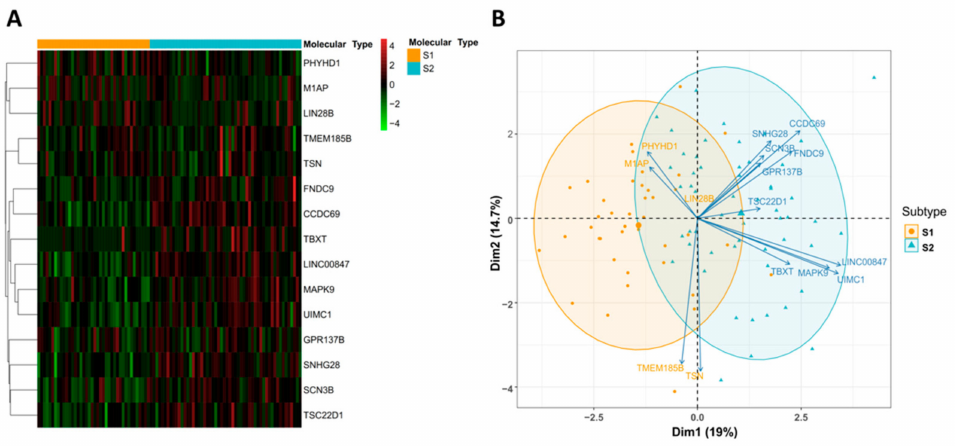
Figure 5. ( A ) Hierarchical clustering analysis of 15 genes in two subtypes. ( B ) Principal component analysis of 15 genes between two subtypes. Table 3. Clinical characteristics of ESCC patients in the validation